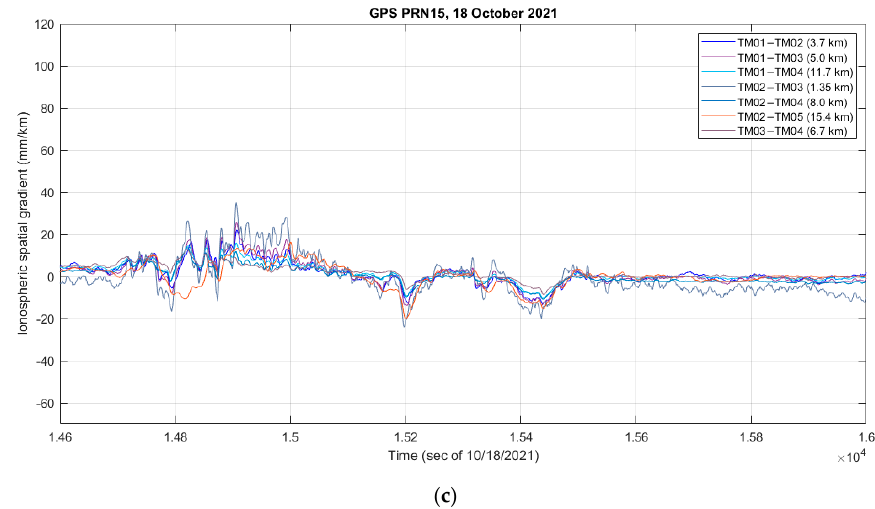
Figure 7. ( a ) Variation in the slant ionospheric delay as observed on GPS PRN15 by a subset of monitoring stations. Elevation angle of 28°–30° across stations during the plotted time period; ( b ) Ionospheric spatial gradient values. Higher values on MSIM-TRO1 and MSIM-TM04 station pairs indicate spatial variation in the ionospheric gradient between the higher North-West segment and the rest of the cluster; ( c ) Ionospheric spatial gradient values observed by the test receiver subset.